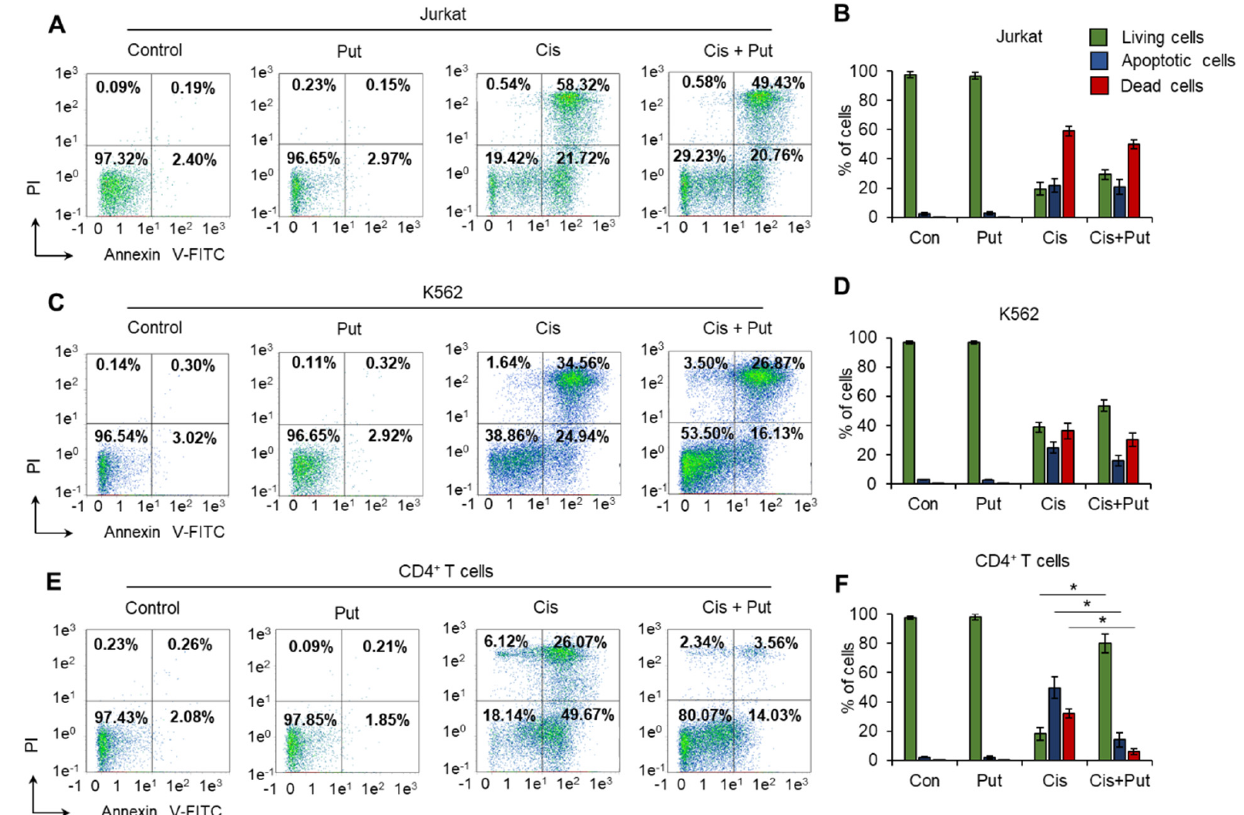
Figure 3. Prevention of cisplatin-induced apoptosis by putrescin (Put) in normal CD4 + T cells. Cells were labeled with annexin V-FITC and propidium iodide, and flow cytometry was performed 72 h after incubation with cisplatin (Cis). Representative plots for cancer cell lines ( A ) Jurkat, ( C ) K562, or ( E ) normal CD4 + T lymphocytes pretreated with Put and incubated with Cis. The proportions of live cells (lower left quadrants), apoptotic cells (lower right quadrants), and dead cells (two upper quadrants) are presented. ( B , D , F ) Histograms of live, apoptotic, and dead cells measured by flow cytometry. n = 4. * p ≤ 0.05.